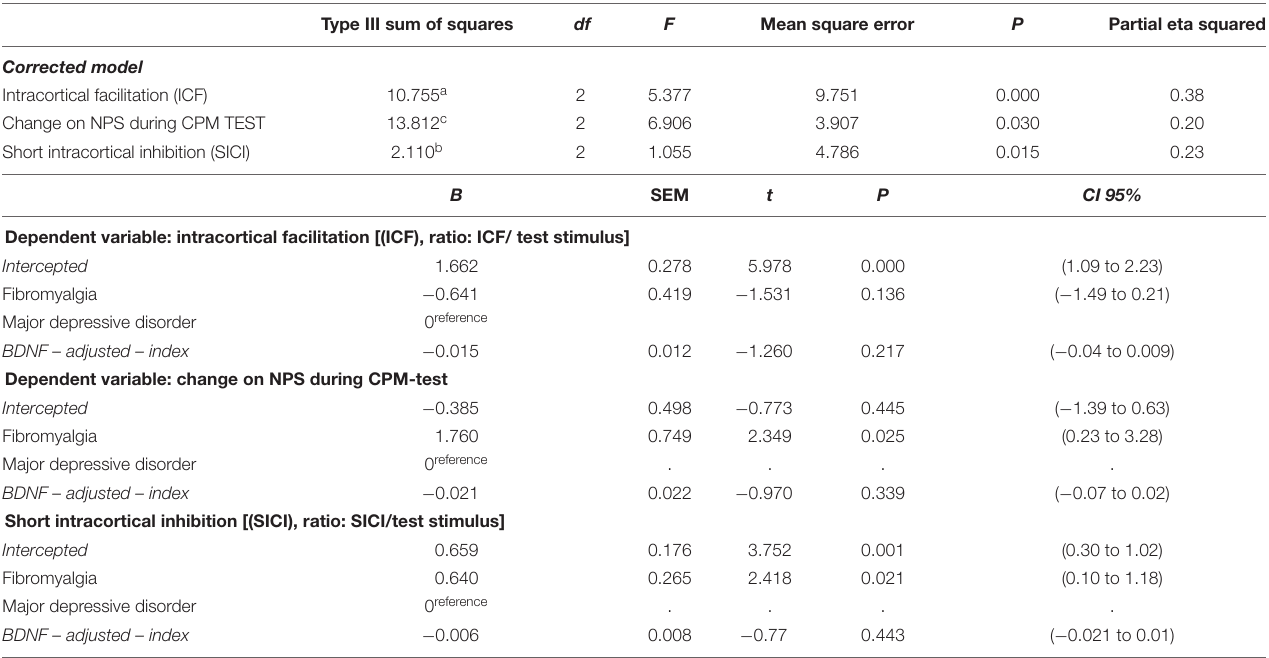
TABLE 4 | Relationship between intracortical inhibition (SICI and ICF) and descendent pain modulating as assessed by the change on NPS during CPM-test with the BDNF according to diagnosis group (FM and MDD) ( n =